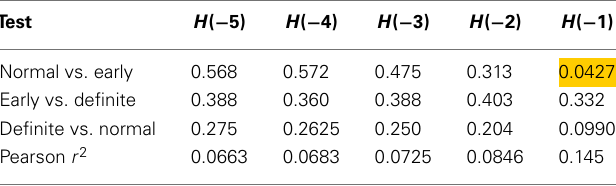
Table 2 | Results of Mann–Whitney tests for Renyi entropy calculated with negative exponents and using method 1